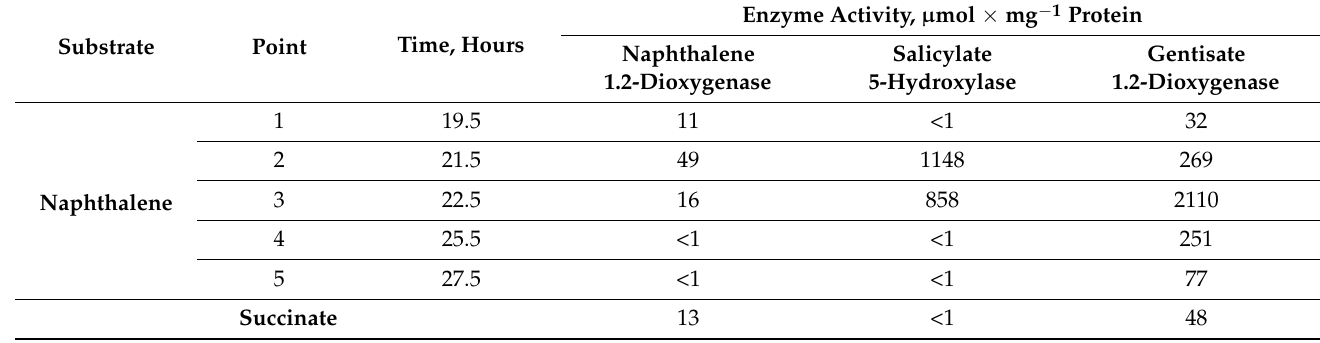
Figure 3. Growth parameters of the Delftia tsuruhatensis ULwDis3 strain in a mineral medium with naphthalene ( A ) and accumulation of the key metabolite of the naphthalene degradation pathway ( B ) (nah—naphthalene, sal—salicylate, gen—gentisate). Table 2. Activity of the key enzymes of naphthalene